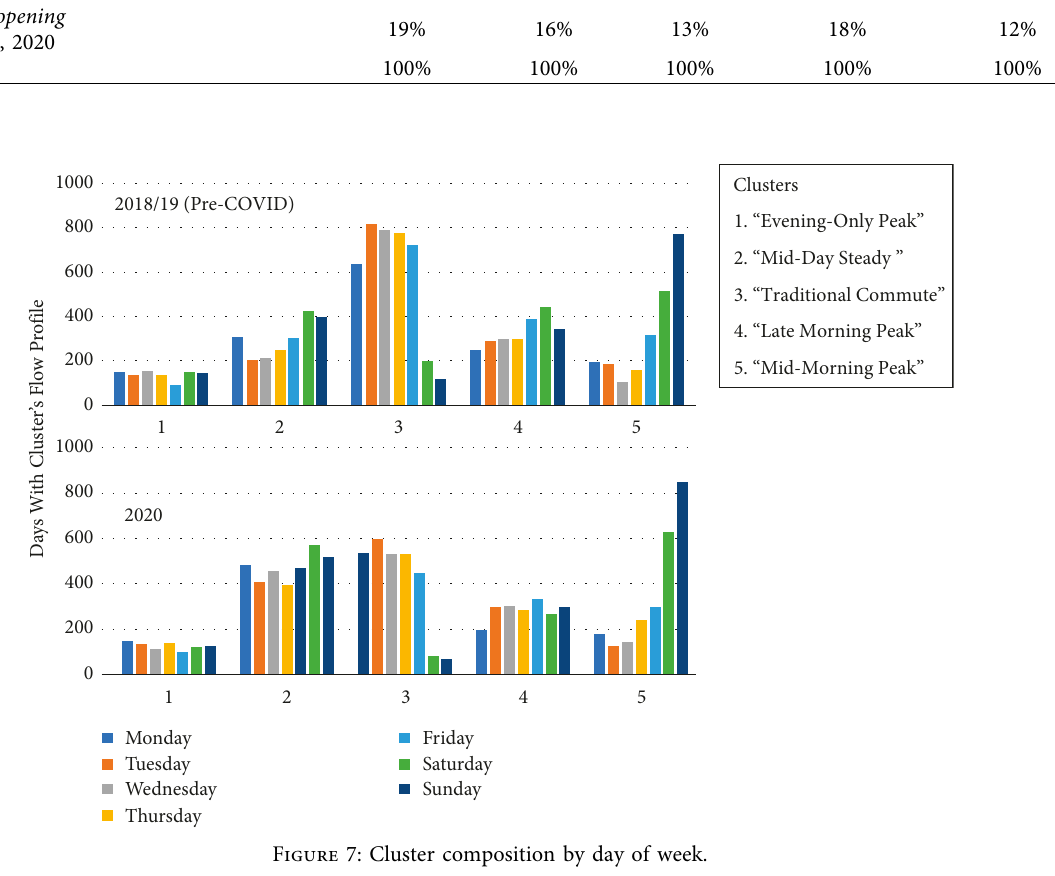
Figure 7: Cluster composition by day of week.